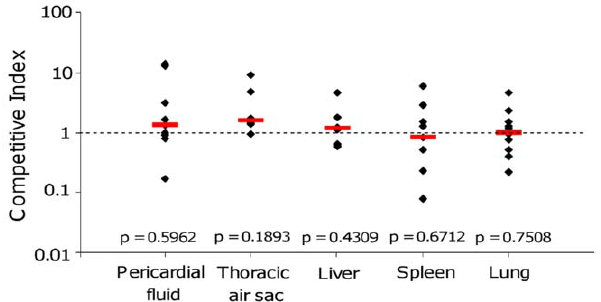
Figure 5. Competition between E. coli strains BEN2908 and BEN2908 D fosT for colonization of chicken organs during avian colibacillosis. Twenty five-day-old SPF White Leghorn chickens were inoculated in the right air sac with strains BEN2908 and BEN2908 D fosT together (each at 5 6 10 6 CFU/chicken). Animals were euthanized 48 h post-inoculation by injection of Nesdonal and then necropsied. The proportion of each strain in organs was monitored and CI were calculated. Horizontal red bars indicate the median of CI and diamonds indicate individual CI. Statistical analyses were conducted using the Mann-Whitney U-test, measuring the difference between CI in organs and in the inoculum. The calculated P values are presented.